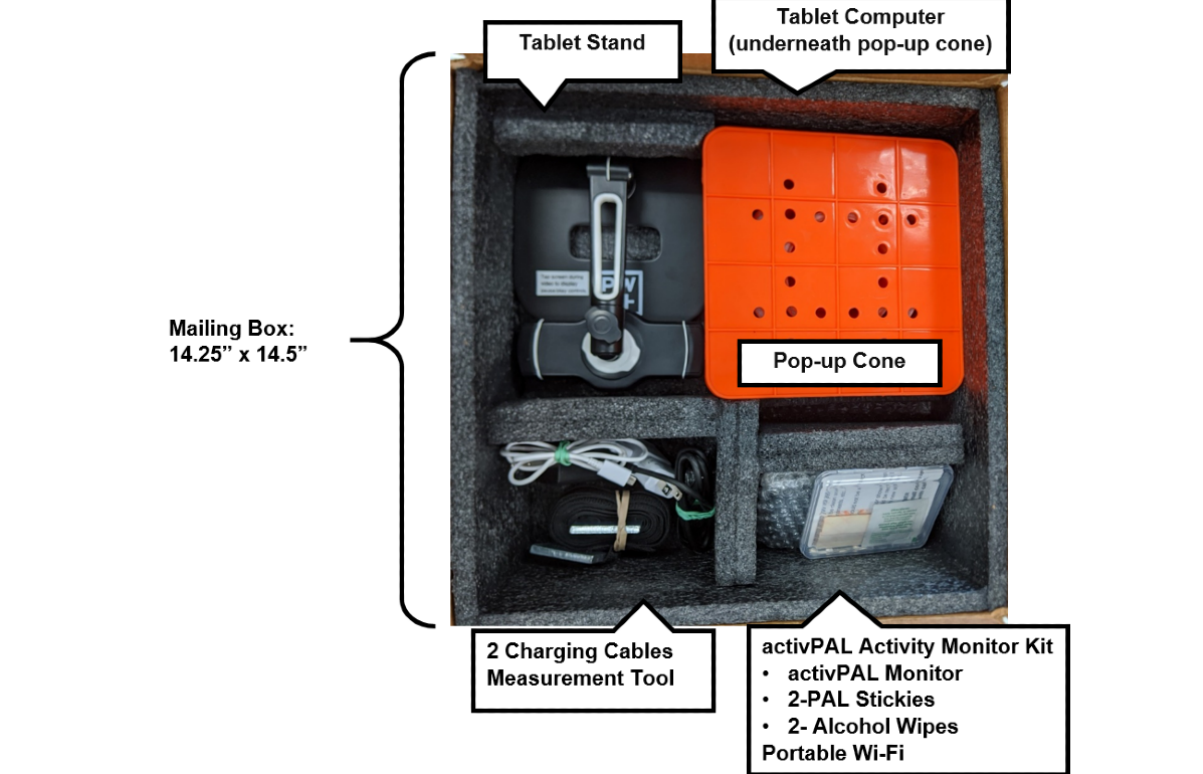
Figure 2. Toolkit for the remote assessment of functional mobility and strength among older cancer survivors.